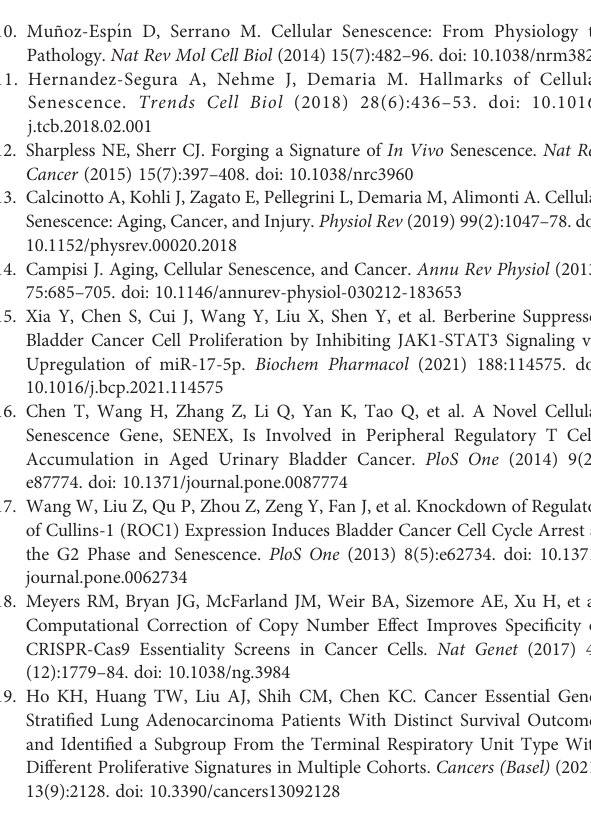
Supplementary Figure 1 | The interaction of 4 genes. Supplementary Figure 2 | The AUC curves of this model in 1, 3, and 5 years. Supplementary Figure 3 | Response to chemotherapy using other drugs in different risk score